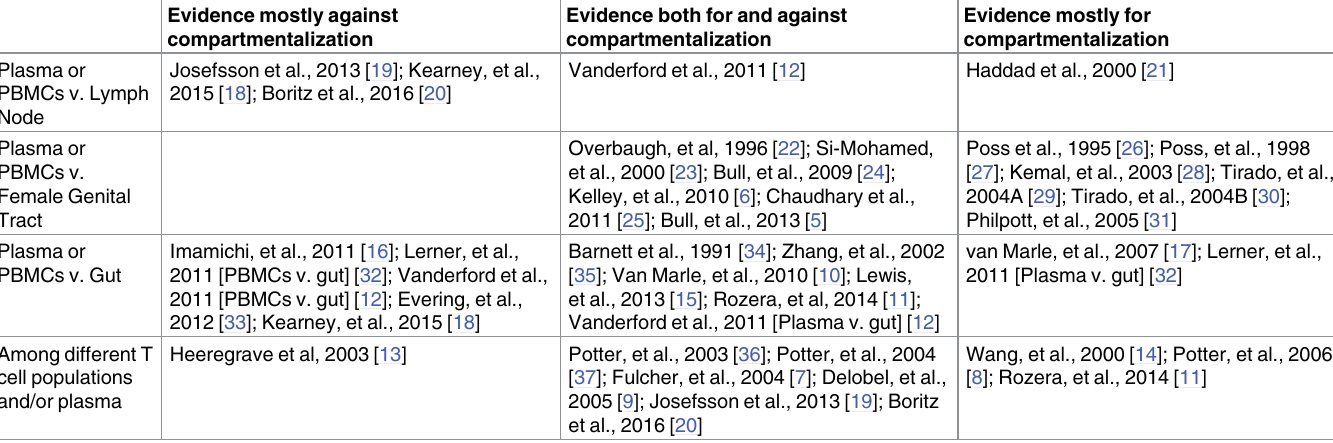
Table 1. Summaryof results from a subset of HIV-1 compartmentalization